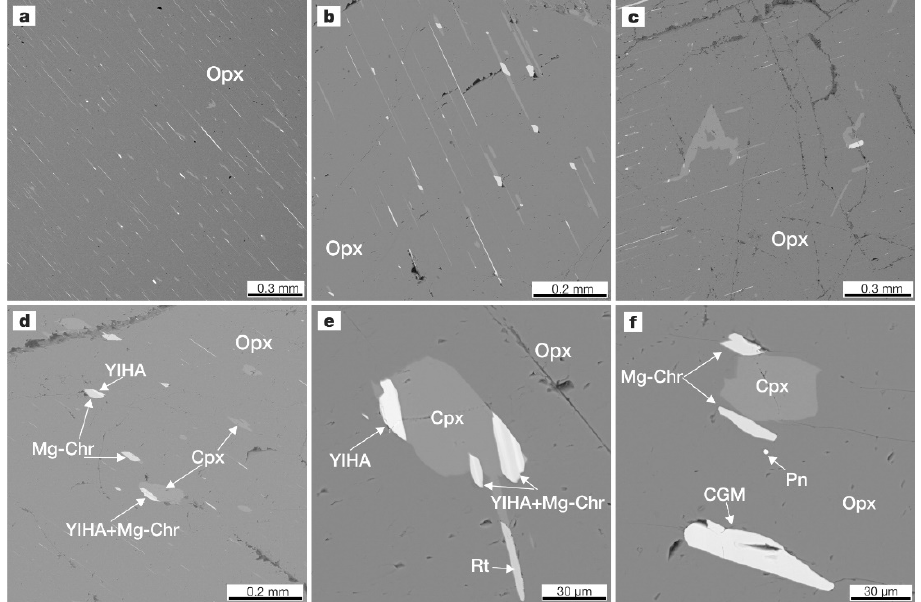
Figure 2. ( a–c ) Back-scattered electron (BSE) images showing the distribution of Cr-diopside (gray) and magnesio-chromite (light gray) inclusions in enstatite; ( d–f ) BSE images showing titanates of the yimengite-hawthorneite series and crichtonite-group minerals associated with titaniferous magnesio-chromite, irregularly-shaped Cr-diopside, rutile and pentlandite. Mineral abbreviations are those described in the Section “Materials and Methods” and Table 1.